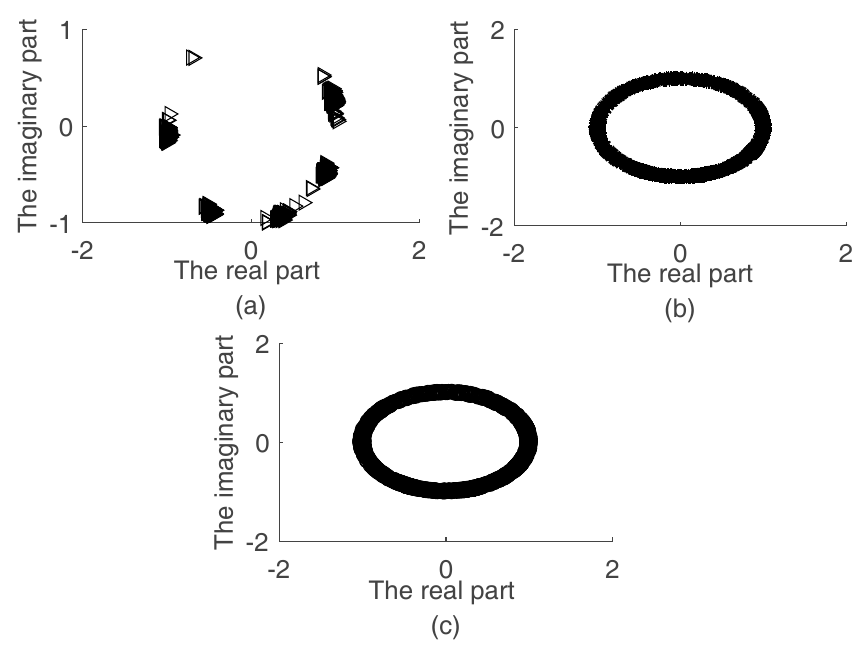
Figure 3. The scatter diagram of { a 2, n , n = 1, · · · , N } for SNR = 15 dB: ( a ) the scatters of the proposed method; ( b ) the scatters of Nie’s method; and ( c ) the scatters of Li’s method.